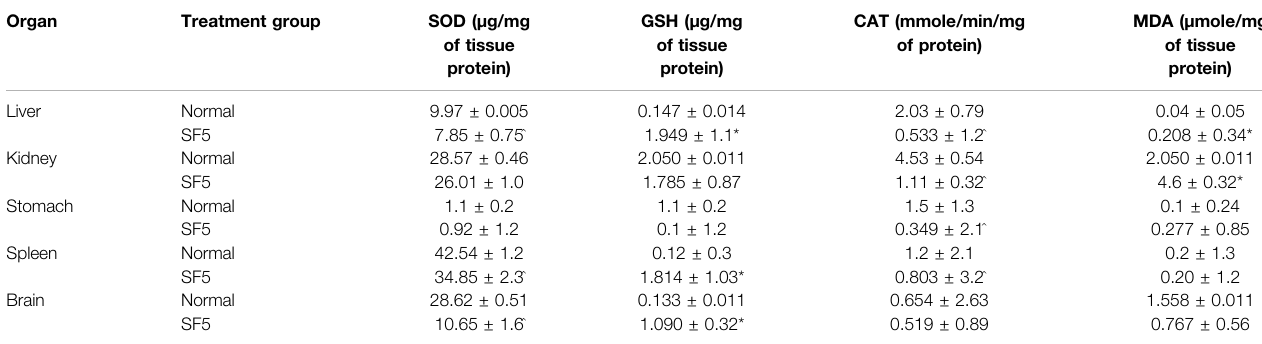
TABLE 2 | Effect of SF5 treatment on oxidative stress markers in the acute toxicity study.